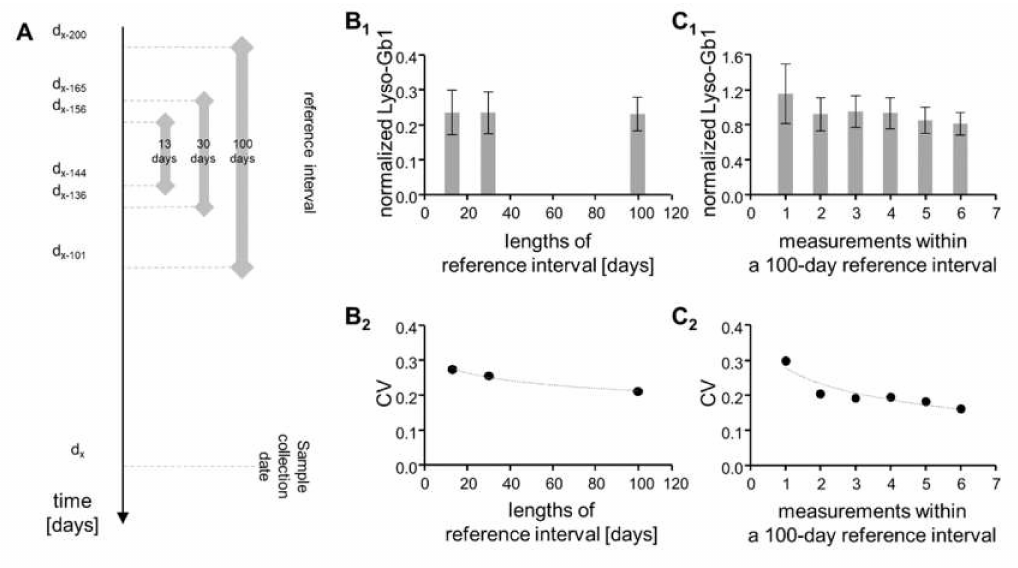
Figure 2. Normalization of Lyso-Gb1 based on the data highlighted in Figure 1A. ( A ) Scheme that depicts the tested normalization strategies. The most recent value (dating from day d x ) is divided by the mean value as calculated from the three indicated reference intervals. ( B ) Mean normalized Lyso-Gb1 ( B 1 ) and corresponding coe ffi cients of variation ( B 2 ) of the normalized values are provided for each of the three reference intervals. ( C ) Mean normalized Lyso-Gb1 ( C 1 ) and corresponding coe ffi cients of variation ( C 2 ) of the normalized values within the 100-day reference interval are plotted against the number of underlying measurements. CV, coe ffi cient of variation; trendlines were set to